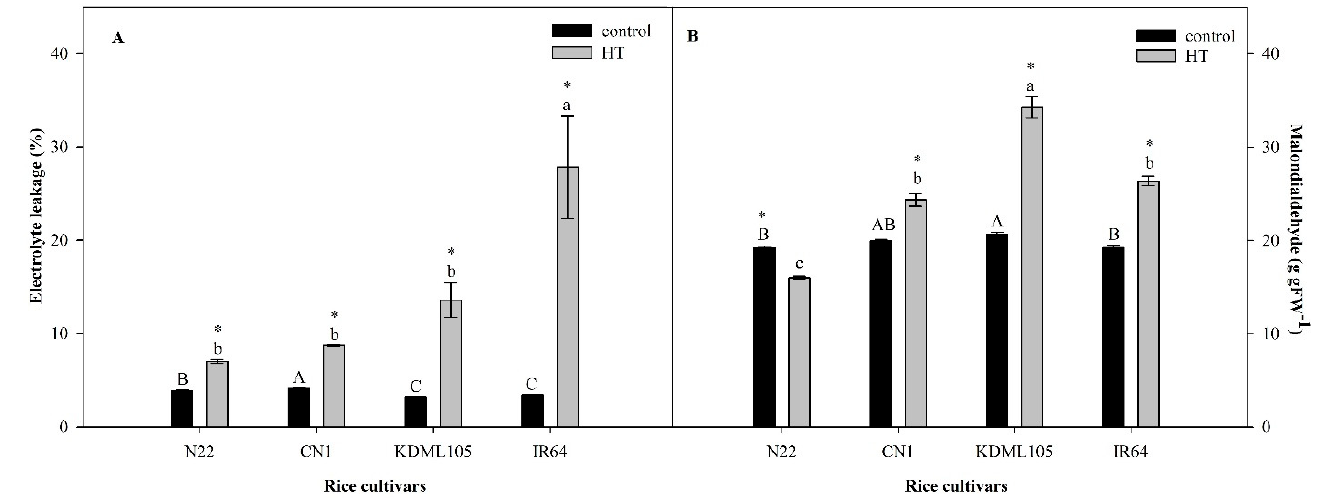
Figure 2. Effect of HT on electrolyte leakage ( A ) and lipid peroxidation ( B ) in four rice cultivars (N22, CN1, KDML105 and IR64). Each bar represents mean ± SE ( n = 3–4). Asterisk (*) indicates significant difference between control and HT in each rice cultivar at p ≤ 0.05 by t test. Different capital letters indicate significant difference of control group in different rice cultivars at p ≤ 0.05 by ANOVA and DMRT, and small letters indicate significant difference of HT in different rice cultivars at p ≤ 0.05 by ANOVA and DMRT.